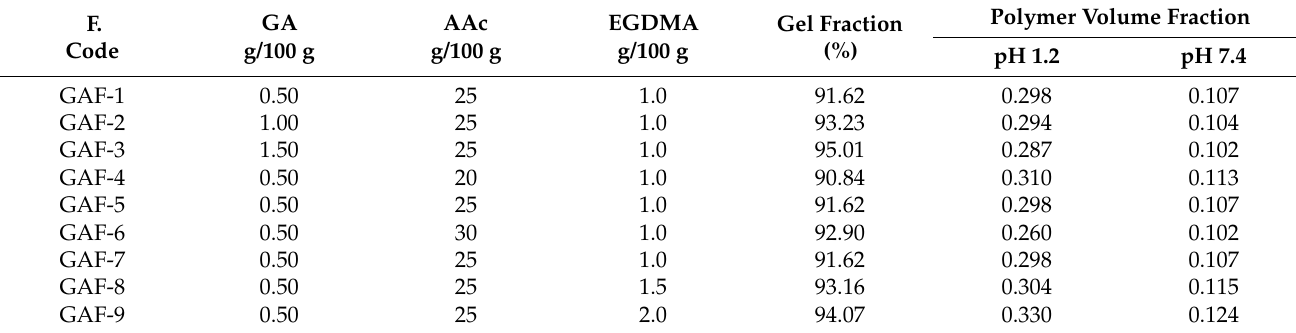
Table 1. Feed ratio scheme for formulations, gel fraction, and polymer volume fraction of GAcPAAc hydrogels.